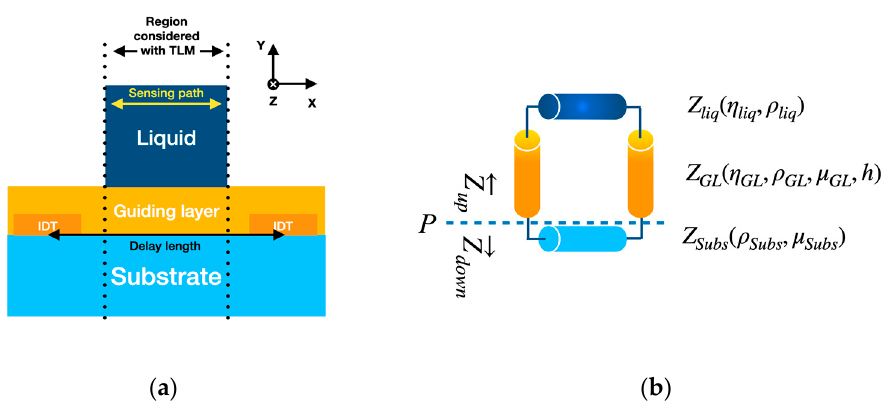
Figure 3. ( a ) Layered structure of a Love wave sensor made of three different materials: substrate rigid solid, a viscoelastic guiding layer, and a Newtonian liquid as the top layer. ( b ) A schematic of the transmission line circuit with the different impedances connected represents the Love wave sensor structure shown in ( a ); the physical parameters used for the characteristic impedance of each layer are also shown. Where Z liq is the impedance for a Newtonian liquid, Z GL the impedance for a viscoelastic guiding layer, and Z Subs the impedance for a rigid substrate, η , ρ , µ and h are, respectively, the viscosity, density, shear modulus, and thickness of the layer.